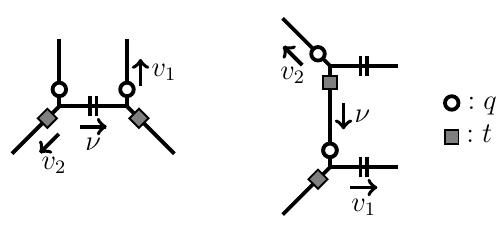
Figure 27 . The assignment of the vectors for determining the framing